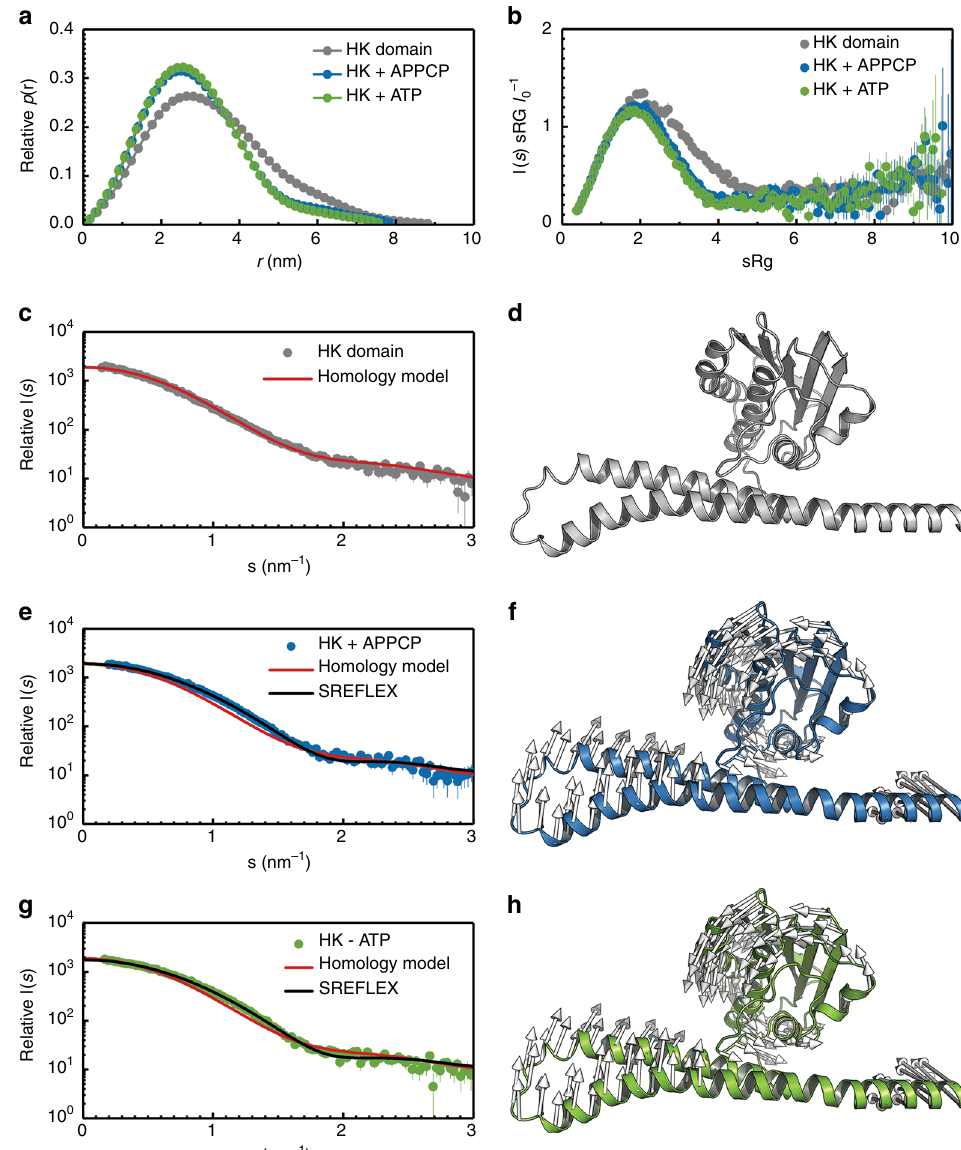
Fig. 5 SAXS analysis of nucleotide binding to the HK domain. Real-space distance distributions p ( r ) of the HK domain with no ligand (gray) and in the presence of 10 µ M of APPCP (blue), or 10 µ M of ATP (green). b Dimensionless Kratky plot of the data in a , highlighting the change toward a more compact and less- fl exible structure when either APPCP or ATP are added to the HK domain. c SAXS data for the ligand-free HK domain, fi tted with the homology model depicted in d . e SAXS data for the Mg-APPCP-bound HK domain, fi tted with the homology model (red), as well as with the best SAXS-re fi ned elastic network conformation (black). f Conformational transitions from the template homology model re fi ned against the Mg-APPCP-bound data in e . Vectors describe the direction of motion. g SAXS data and corresponding fi ts as in e for the Mg-ATP bound HK domain. h The derived conformational transitions from g are virtually identical to the ones obtained for Mg-APPCP in f . No effect was noted upon addition of the protein kinase C inhibitor Ro Isothermal titration calorimetry . Calorimetric titrations were carried out at 20 °C Microscale thermophoresis . Ks -Amt5 was labeled using the Monolith with a VP-ITC microcalorimeter (MicroCal/GE Healthcare), following established Protein Labeling Kit RED-tris-NTA (NanoTemper Technologies). The protocols 6,39 . The sample cell contained 100 µ M of Ks -Amt5 426 – 679 in 1.437mL of labeling reaction was performed according to the manufacturer ’ s instructions in size-exclusion buffer using a concentration of 0.2 – 0.5 µ M protein and 0.1 – 0.2 µ M buffer solution consisting of 50 mM Tris/HCl pH 8.0, 100mM NaCl and 2mM of dye at room temperature for 30 min. Concentration series of ligands (NH 4 + , MgCl. Solutions of 1.3mM of potential ligands such as ATP, ADP, GTP (Jena Biosciences) or ATP- γ S (AppliChem) were freshly prepared in the same buffer. All CH 3 NH 3 + , and Na + ) were prepared using size-exclusion buffer, producing solutions were degassed and incubated at 20 °C before the titration runs. After the ligand concentrations ranging from 1.5 µ M to 50mM. For the measurement, fi rst ligand injection of 4 µ L, 20 injections of 14 µ L each or 28 injections of 10 µ L each ligand dilution was mixed with one volume of labeled Ks -Amt5 protein. each were titrated into the sample cell while stirring at 300 rpm. The total time After 30 min incubation, the samples were loaded into Monolith NT.115 between two injections was 240 s. Each experiment was done in triplicates and Premium Treated Capillaries (NanoTemper Technologies) and microscale ther- blank assays were performed in the absence of protein under otherwise identical mophoresis (MST) was measured using a Monolith NT.115 instrument (Nano- experimental conditions. The titration peaks were converted to heat and plotted as Temper Technologies) at a temperature of 22°C. Instrument parameters a function of the molar ratio of ligand to protein after volume displacement cor- were adjusted to 40 % LED power and 60 % MST power. Data of three rections. Data points were integrated and fi tted in NITPIC 40 and SEDPHAT 41 independent measurements were analyzed using the signal from MST-off time of 2 – 3s and a MST-on time of 0.5 – 3 s (MO.Af fi nity Analysis software using a single-binding-site model. Final fi gures were prepared using GUSSI 42 .